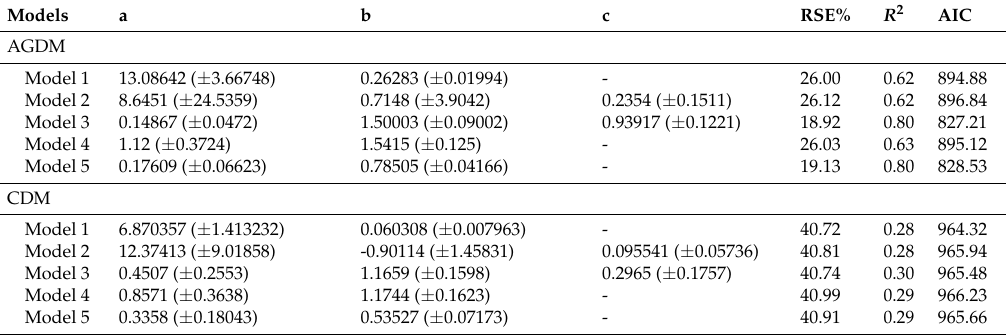
Table 2. Coefficients and statistics for the five allometric models (Models 1–5) for estimating